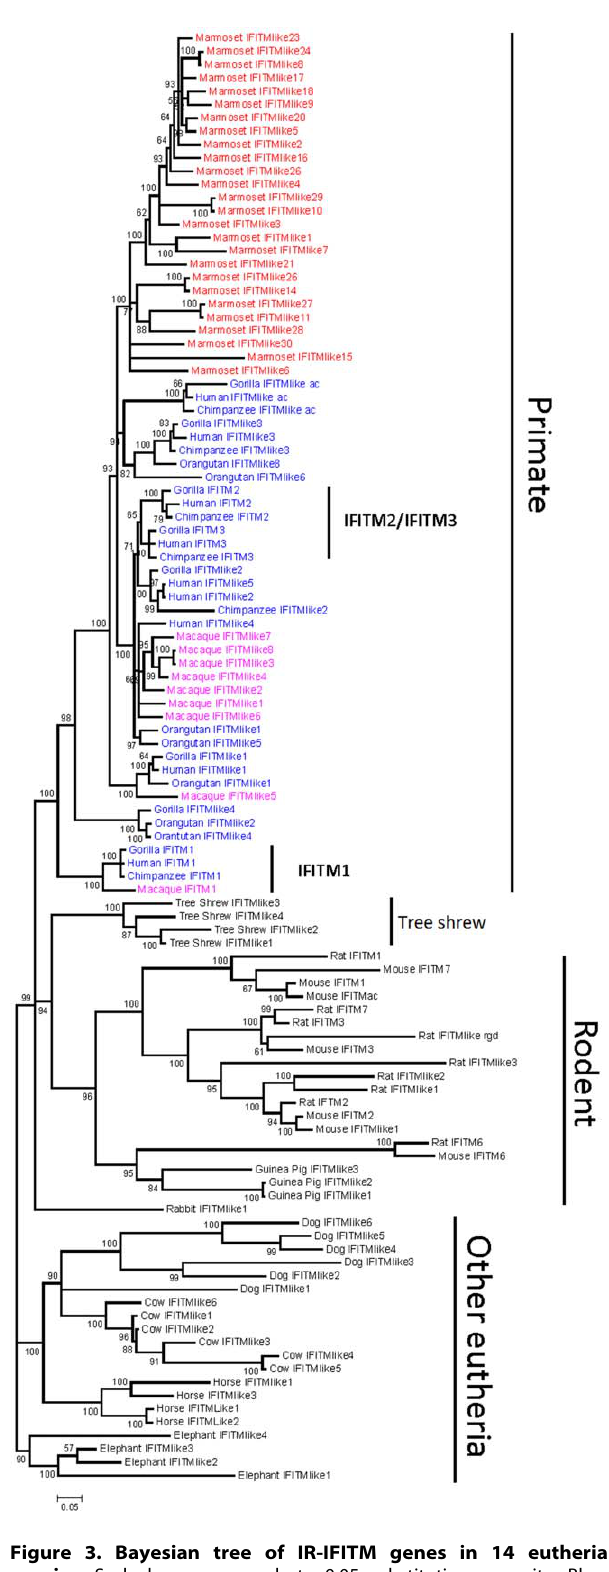
Figure 3. Bayesian tree of IR-IFITM genes in 14 eutheria species. Scale bar corresponds to 0.05 substitutions per site. Blue, purple and red represent hominids (human, chimpanzee, gorilla and orangutan), Old World monkey (macaque) and New World monkey (marmoset), respectively. Other species are shown in black.